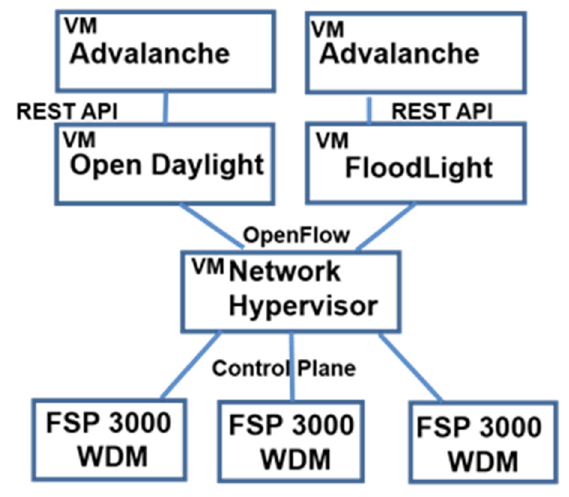
Figure 4. Software control plane architecture for cloud service provider with two